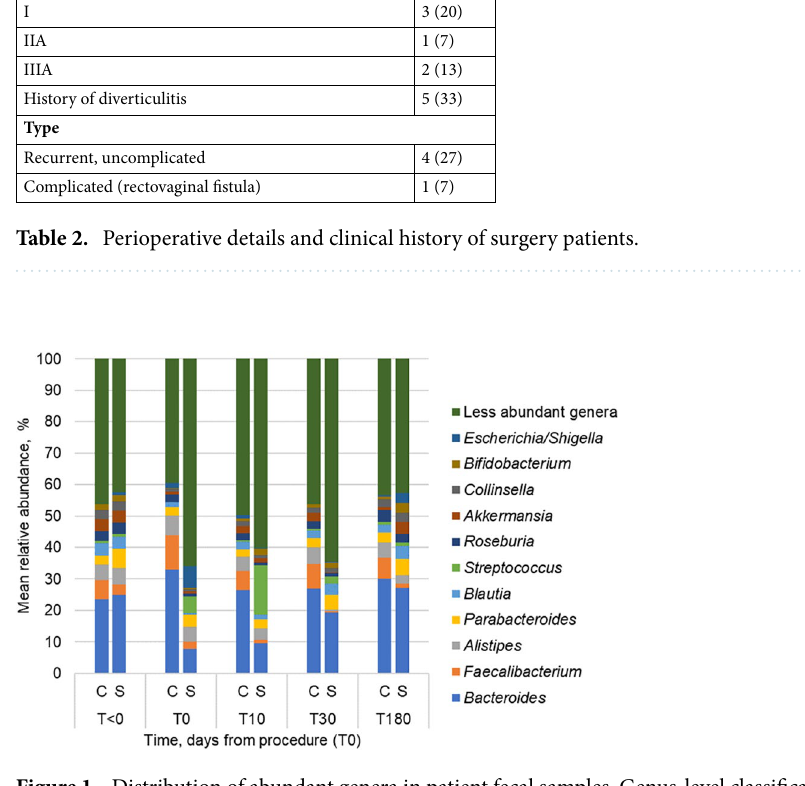
Figure 1. Distribution of abundant genera in patient fecal samples. Genus-level classification of predominant OTUs among patients that underwent colonoscopy (c) and surgery (s) over study